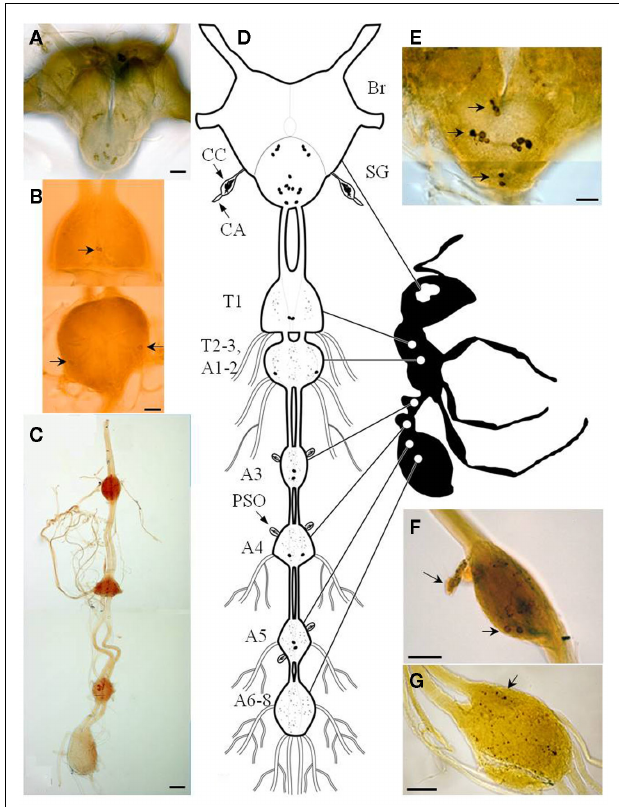
FIGURE 1 | Diagram of the central nervous system of the fire ant adult. Photomicrographs of brain and subesophageal ganglion (A) , immunoreactive neurons in thoracic ganglia [ (B) , arrows ], and abdominal ganglia (C) . Schematic drawing of fire ant adult CNS and PBAN-like immunoreactivity (D) . Posterior view of an adult Br–SG complex showing somata in the SG and near the esophageal foramen [ (E) , arrows ]. Immunoreactive neurons projecting into perisympathetic organs in abdominal ganglion [ (F) , arrows ].Terminal ganglion (sixth–eighth neuromeres) containing a densely stained region of varicosities [ (G) , arrow ; Br, brain; SG, subesophageal ganglion; CC, corpora cardiaca; CA, corpora allata; PSO, perisympathetic organ;T1–3, first–third thoracic ganglia; A1–8, first–eight abdominal ganglia]. Bar = 50 μ m (Choi et al., 2009).